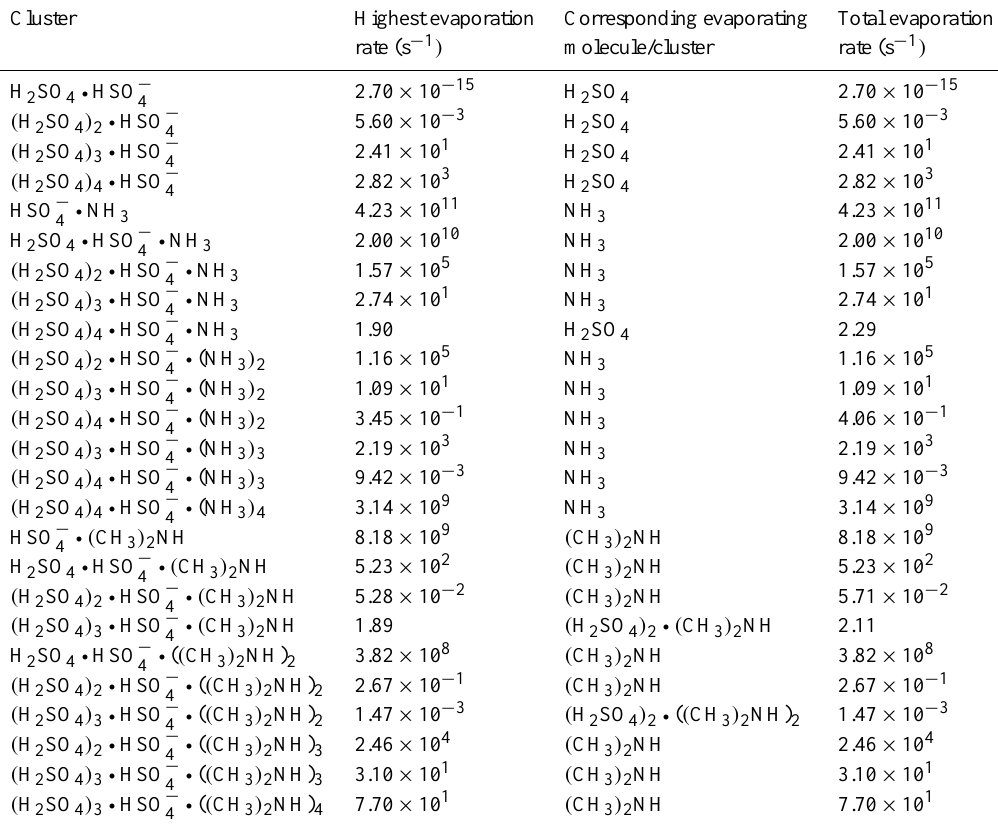
Table 1. Highest evaporation rate, corresponding evaporating molecule/cluster and total evaporation rate at 298.15K for different negatively charged clusters